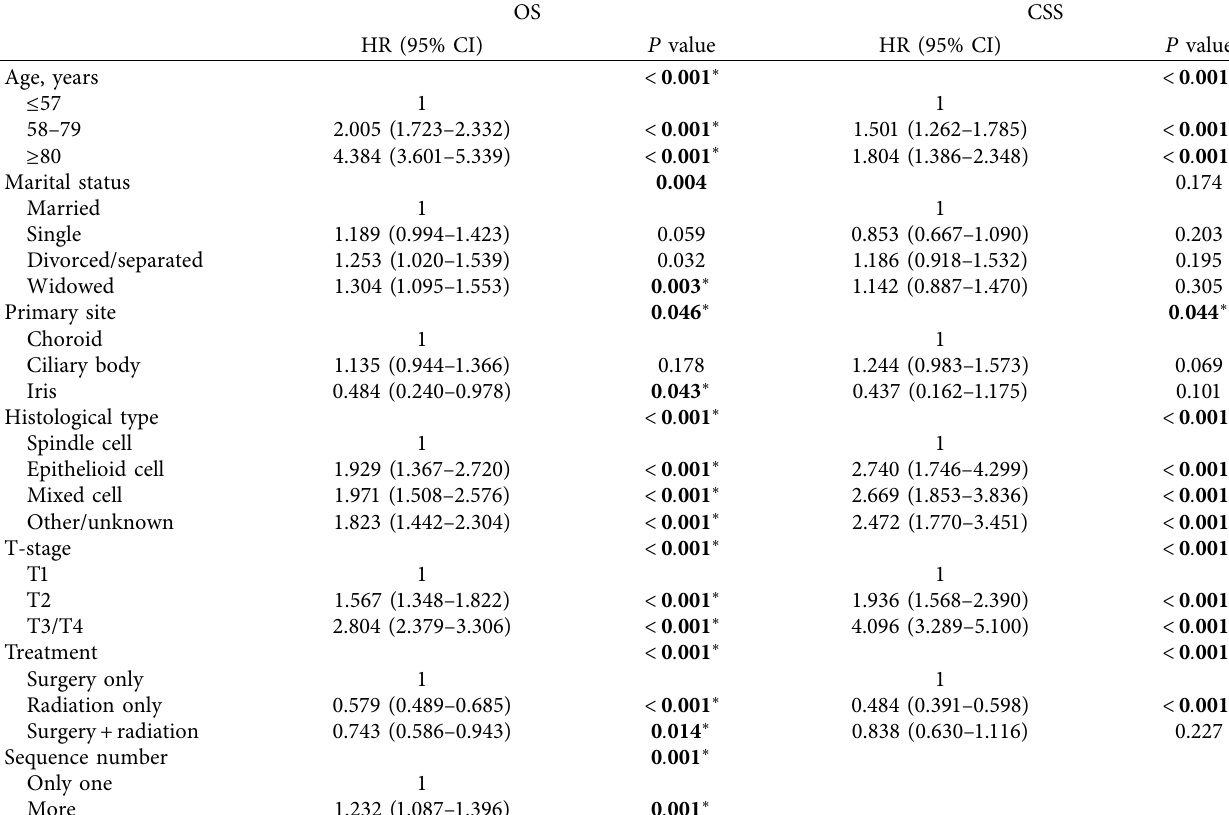
Table 3: Multivariate Cox regression analysis of OS and CSS in the training